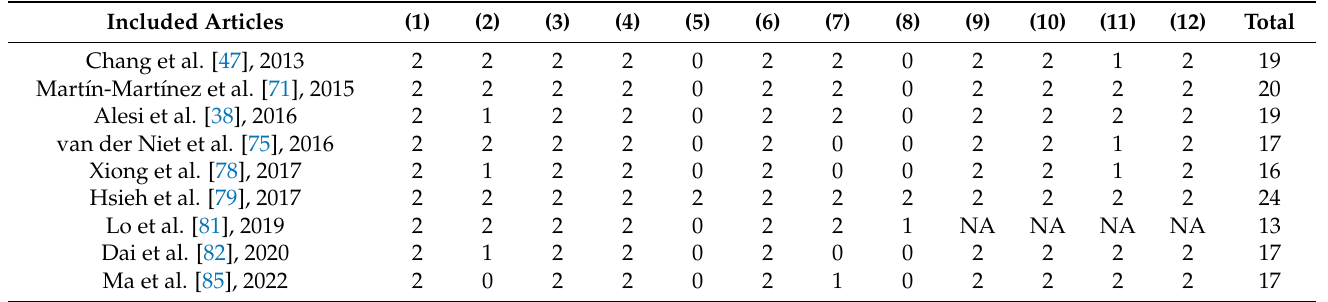
Table 3. Results of the quality assessment of the included non-RRCTs and